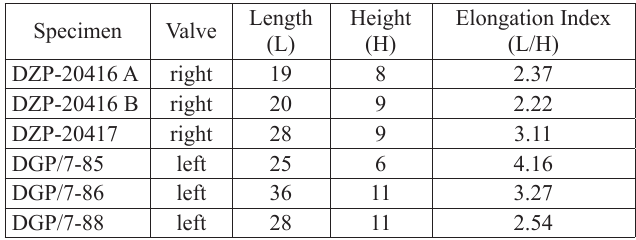
Table 2. Measurements (in mm) of the valves of Leinzia similis (Hold- haus, 1918) sensu